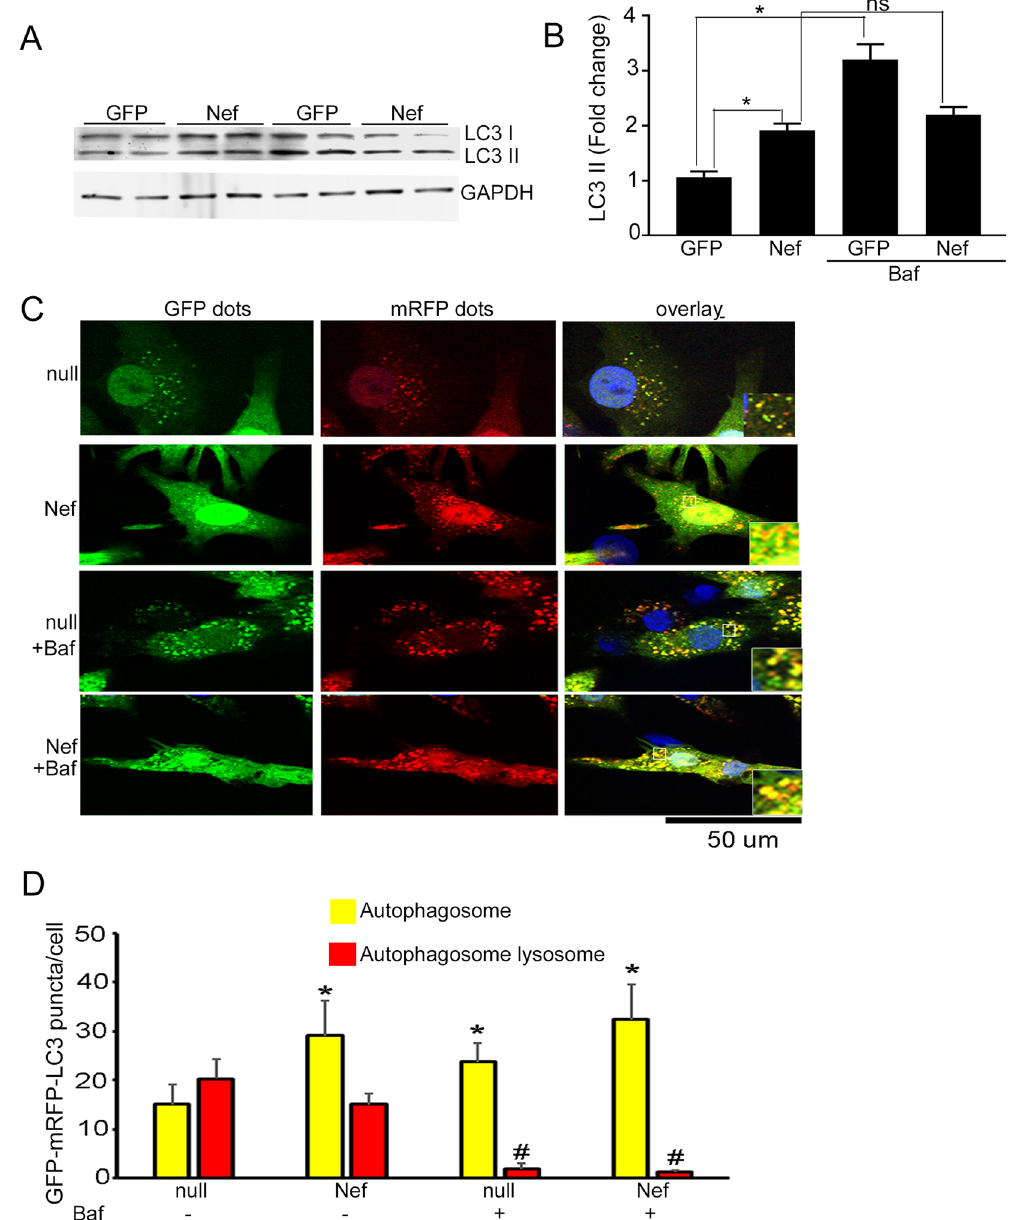
Figure 3. Nef blocks cellular autophagy at the terminal step. ( A , B ) Nef caused accumulation of autophagy marker protein LC3-II in cardiomyocytes. NRVCs were transduced with Ad-Nef or Ad-GFP for 48 hours and LC3 expression of was measured in total protein lysate by Western blot. Nef caused accumulation of autophagy marker protein LC3-II in cardiomyocytes. Autophagy flux assay was done using bafilomycin suggested that Nef causes blockage of autophagy flux in the cardiomyocytes (n = 6/group, * P < 0.05). ( C , D ) Progression of autophagy was monitored using autophagy reporter Ad-tfLC3. Representative images show the autophagosome (yellow) and autophagosome and lysosome fused puncta (red) in the cardiomyocytes transduced with Ad-tfLC3 (n = 4 wells/group, * P < 0.05, vs Ad-null, # P < 0.05, significant vs